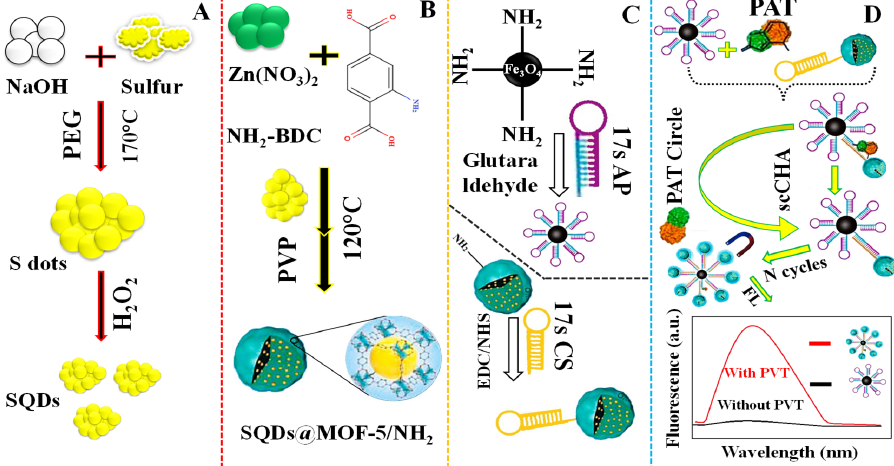
Figure 10. ( A ) Depiction of the SQDs synthesis procedure: ( B ) Diagram of the SQDs@MOF-5-NH 3 preparation method; ( C ) The DNA hairpin coupling mechanism involving Fe3O4-NH2 and